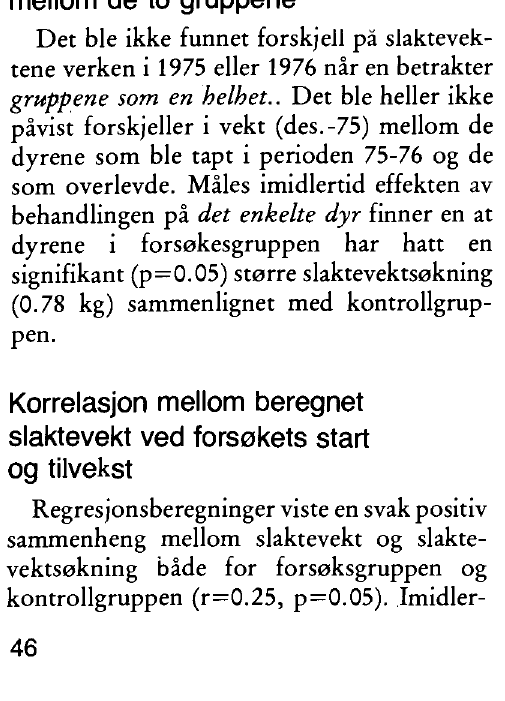
Fig. 1. Grafisk fremstilling av de to regresjonslinjene. X er beregnet slaktevekt ved forsøkets begynnelse (des. 75), og Y slaktevektsøkning frem til des. 76. Diskusjon Det har lenge vært diskutert om behandling tilveksten. Dette forsøket viste at behandlede dyr hadde en signifikant større tilvekst, og at denne økningen var uavhengig av dyrets vekt ved behandlingen. Selv om forskjellen ikke er større enn i underkant av ett kilo pr. dyr, vil det totalt sett gi positive virkninger for innen reindriften. Dette er forsøkt vist ved en enkel økonomisk betrakt ning i neste